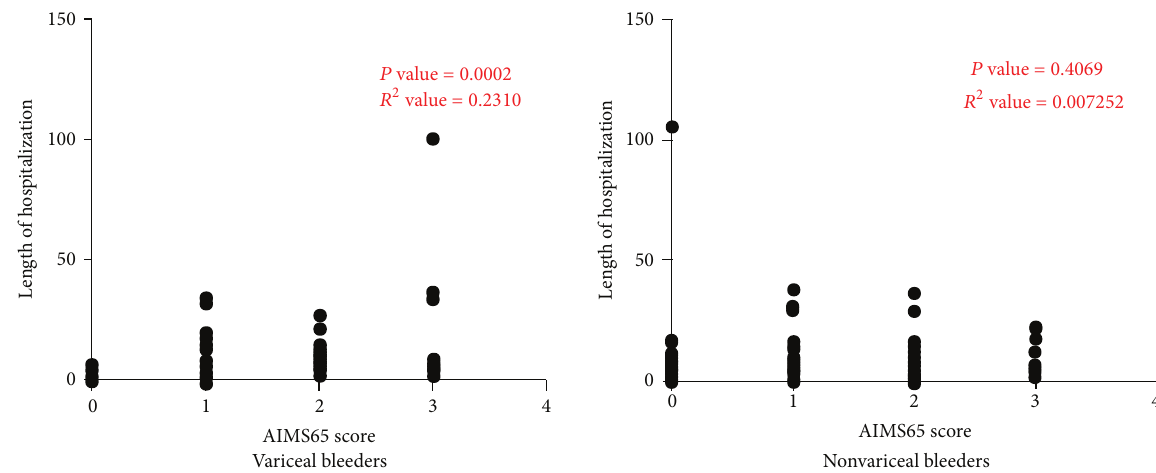
Figure 8: Statistically significant direct correlation was found between the length of hospitalization and AIMS65 scores in cirrhotic patients with variceal bleed but not in cirrhotic patients with nonvariceal bleed.